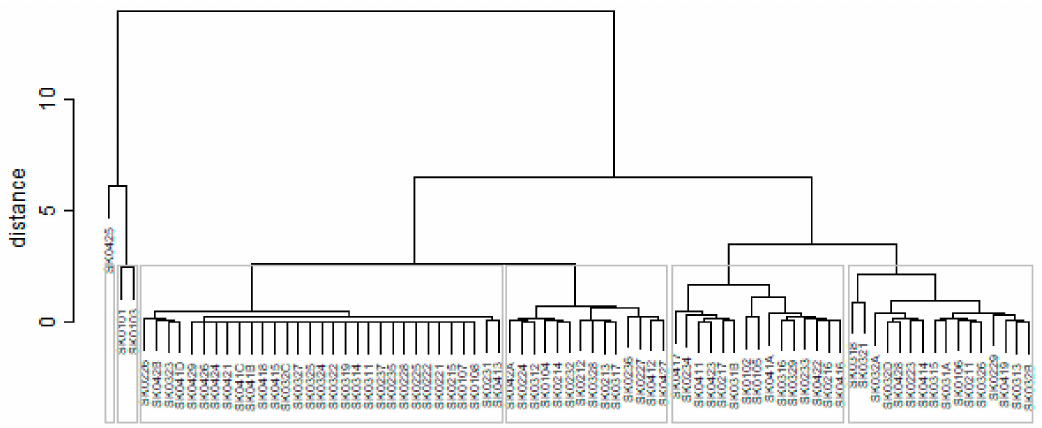
Figure 5. Medical equipment dendrogram of the districts in the whole explored period. Source: own elaboration by the